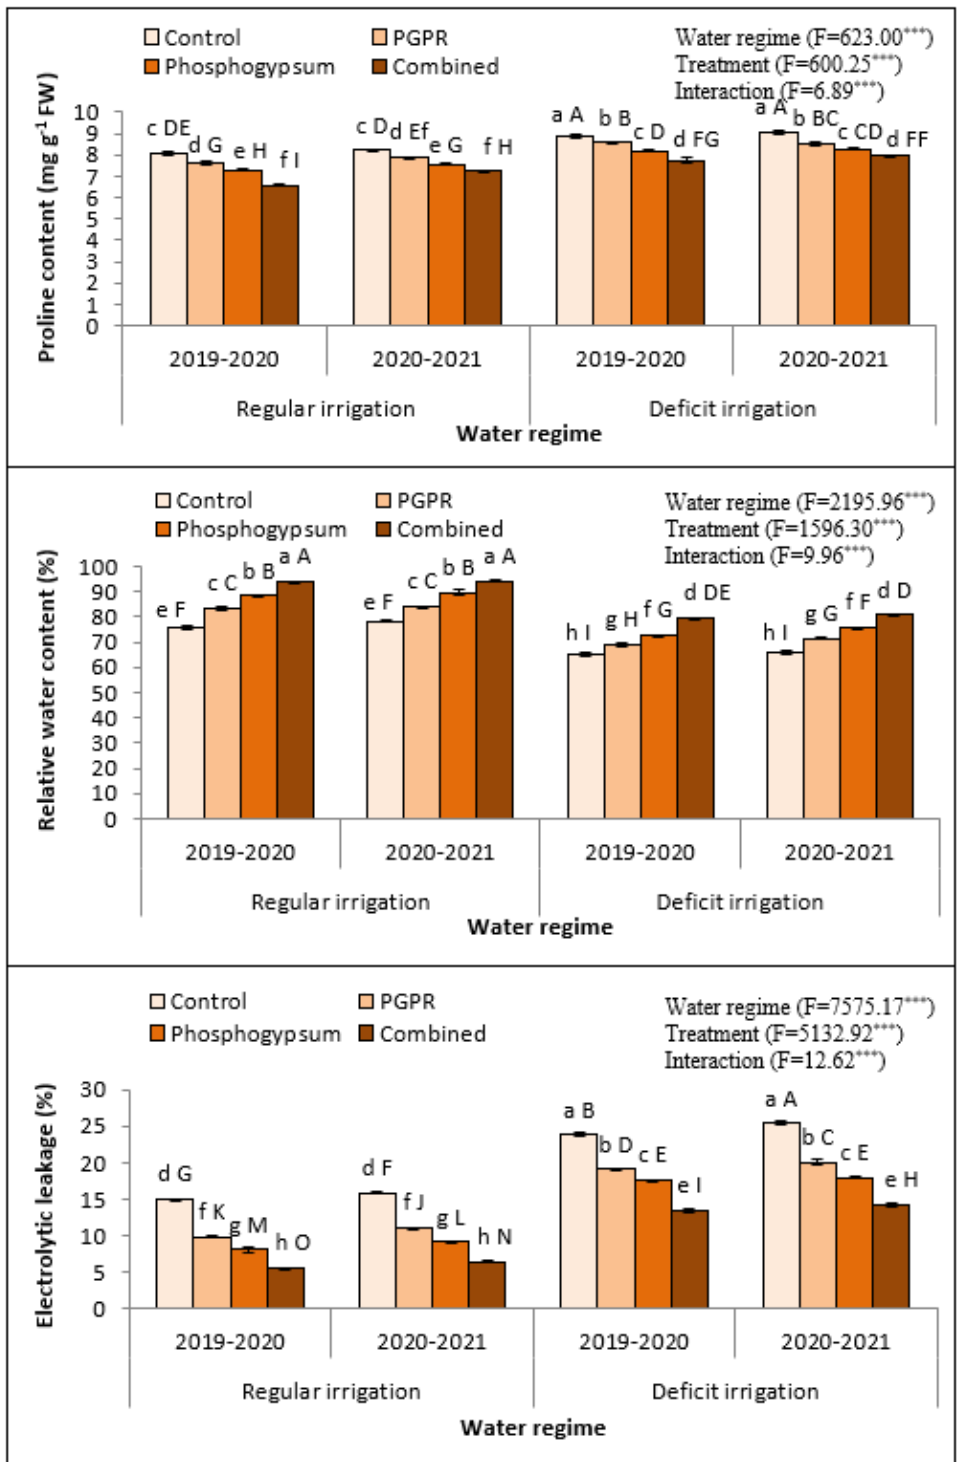
Figure 1. Response of proline content, relative water content, and electrolyte leakage in quinoa ( Chenopodium quinoa ) to different water regimes in the presence of singular or dual application of PGPR and phosphogypsum during two growing seasons (2019–2020 and 2020–2021). Different lowercase letters on the same columns of the same season are significant according to the Tukey’s test ( p ≤ 0.05) and different uppercase letters are significant regardless of the growing season according to the Tukey’s test ( p ≤ 0.05). Data are Means ± SD and n = 3. *** denotes significance at p ≤ 0.001.